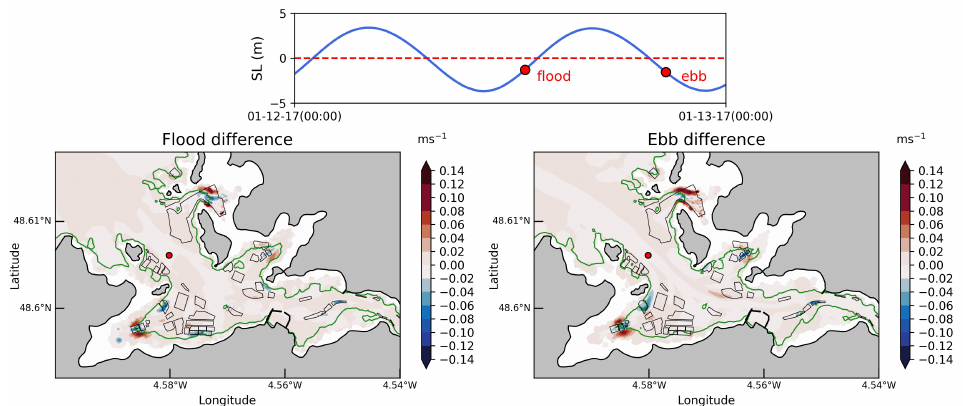
Figure 10. Differences in current magnitudes between simulations E 3 and E 2 at times of local peak flood and ebb near oyster tables during a mean spring tidal cycle. Positive values account for increased current magnitudes with the new parametrisation (E 3 ), while negative values exhibit decreased current magnitudes. The green line corresponds to a total water depth of 0.8 m, the height of the upper side of oyster